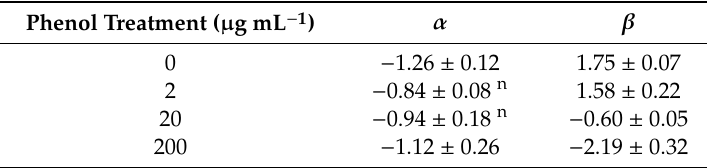
Table 4. Competitive coe ffi cients of M. aeruginosa and C. pyrenoidosa in